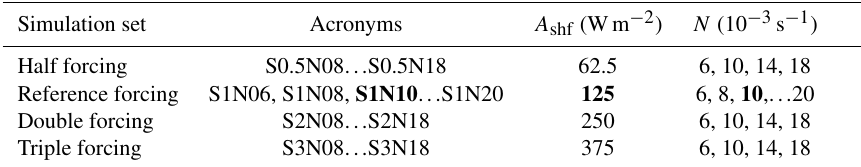
Figure 1. Valley topography with a schematic representation of volumes and tracer mass fluxes and a typical profile of potential temperature at the centre of the valley after a number of hours of model integration. The valley is homogeneous in y direction and is 10km long. The valley volume is split into three time-dependent parts (indicated by grey lines): the convective boundary layer ( V 1 ), the slope wind layer ( V 2 ), and the stable core ( V 3 ). The volume of the atmosphere above the valley ( V 4 ) is assumed to be time invariant. Notice that V 2 is the sum of the two-slope wind layers on the two valley sides. Shown is regime 1 for well-defined volumes. See text for explanation of regime 1 and 2. Black arrows illustrate some typical tracer trajectories. Thick red arrows represent bulk tracer mass fluxes between the volumes. Single headed arrows are used for bulk fluxes, which are predominately directed upwards, while double headed arrows represent integrals of local fluxes, which change sign either in time or along the interface between volumes. Table 1. An overview of different sets of simulations. The reference simulation S1N10 is highlighted using bold typeset. See text for further